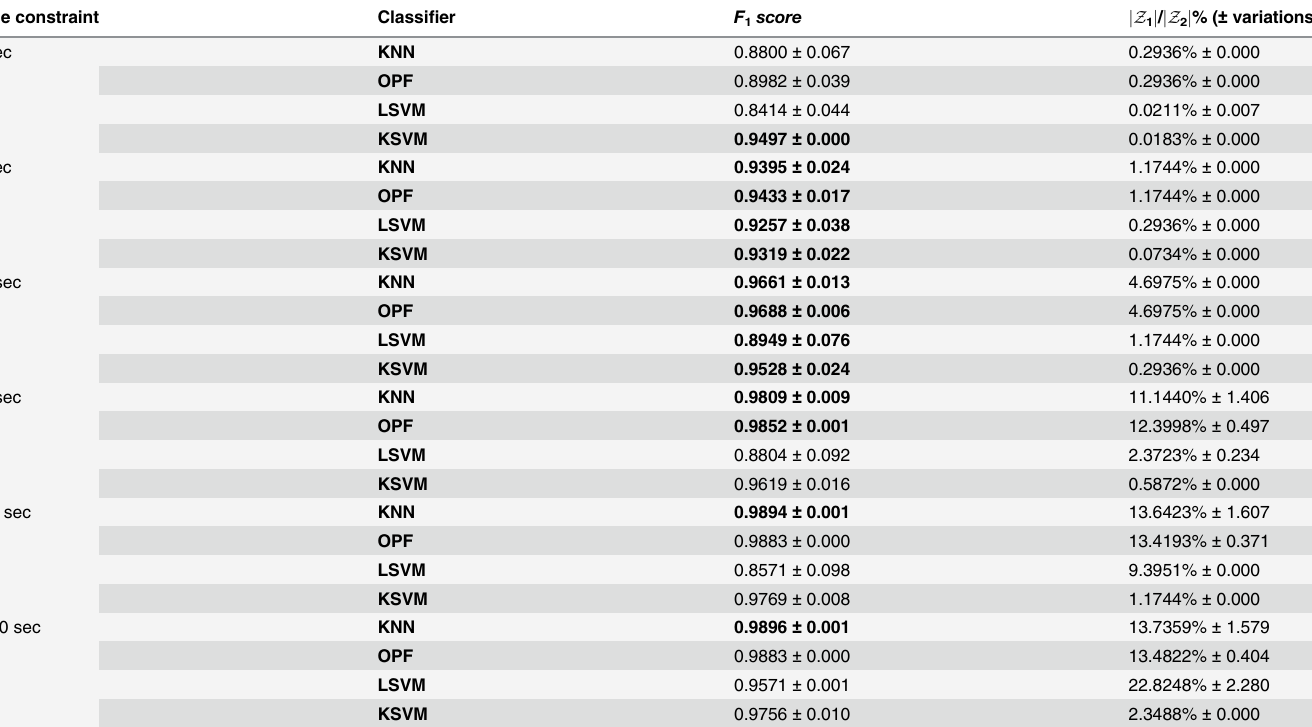
Table 5. IJCNN dataset: Predictivity performance over Z 3 and final training set size, j Z 1 j as a percentual of j Z 2 j , for each classification model and learning time constraint using the proposed